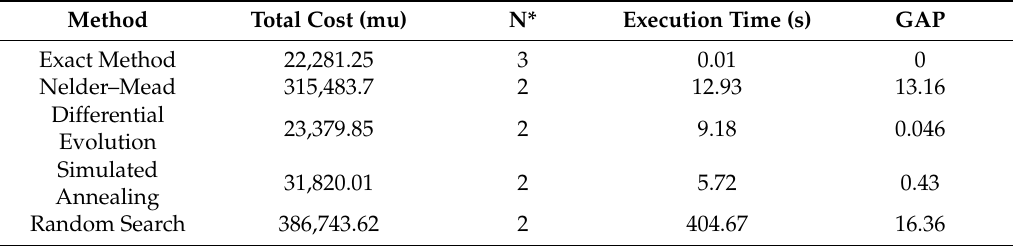
Table 8. Comparative summary of the performance of the used